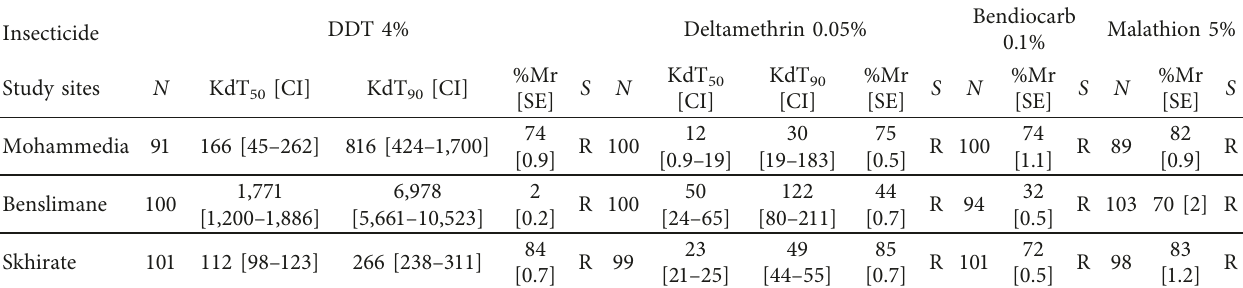
Table 1: Susceptibility of Culex pipiens to DDT, deltamethrin, bendiocarb, and malathion in Mohammedia, Benslimane, and Skhirate. Insecticide DDT 4%